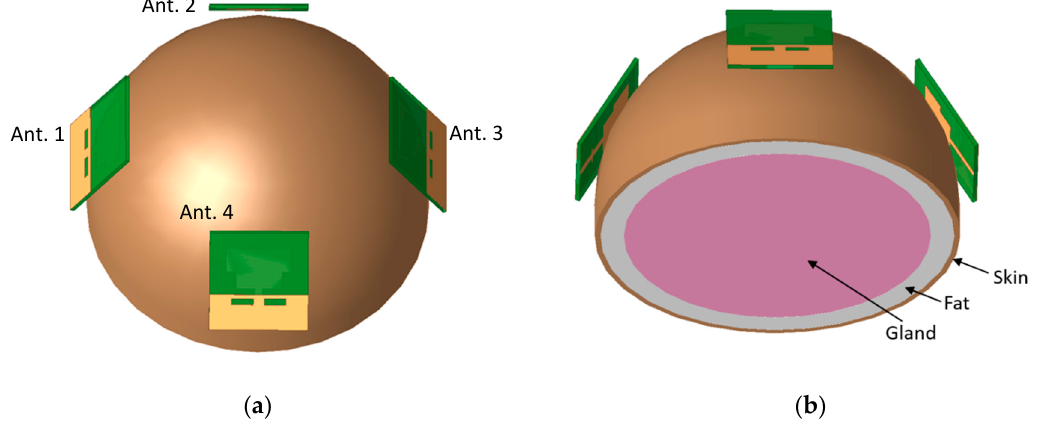
Figure 17. Breast model with four antennas designed to analyse the influence of biological tissue in the antenna response: ( a ) Top view; ( b ) Bottom view.